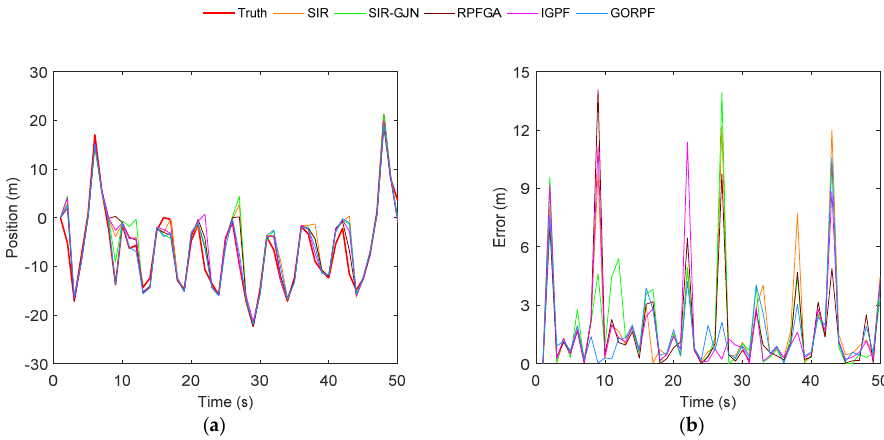
Figure 5. Target tracking performance of the five particle filter-based algorithms (with 20 particles) under normal measurement noise condition ( σ 2 v = 1). ( a ) Tracking trajectories; ( b ) Absolute errors at each time